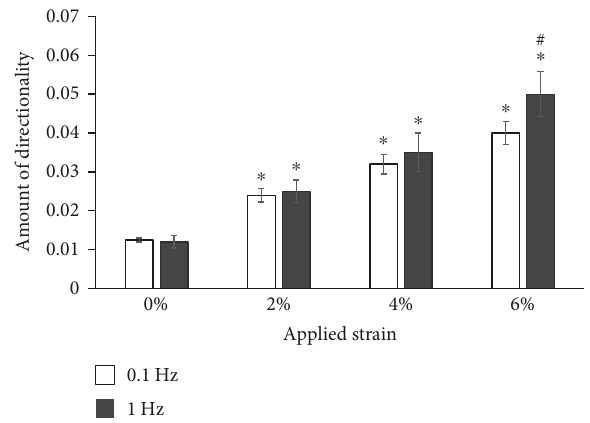
Figure 4: E ff ect of uniaxial tensile loading on matrix organization of ASC-encapsulated 3D collagen sca ff olds. Quanti fi ed directionality of ASC-seeded collagen constructs subjected to 7 days of uniaxial loading at 0%, 2%, 4%, and 6% strains at 0.1Hz and 1Hz frequencies after consolidating the directionality histograms of SEM images obtained using ImageJ analysis shown in Figures 2 and 3. ∗ represents statistical di ff erence from the adjacent strain group. # denotes statistical signi fi cance between same strain groups at di ff erent frequencies. The directionality of collagen fi bers increases with an increase in the magnitude of strain but largely remains una ff ected by the change in frequency (except for 6%